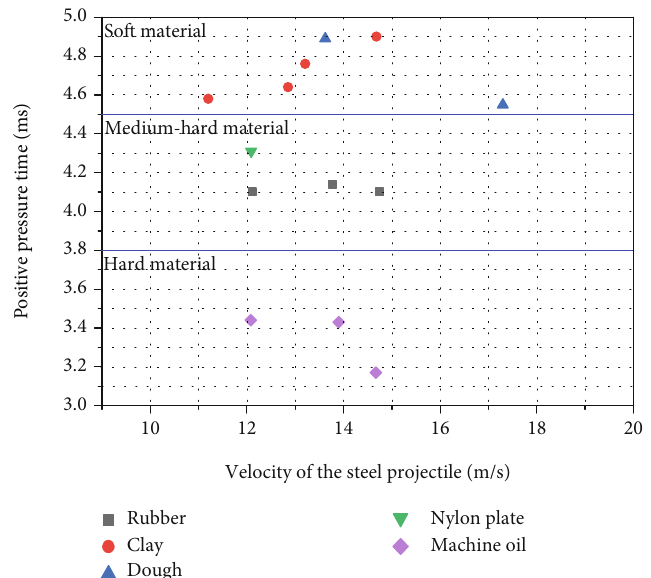
Figure 20: Positive pressure time of stress waves in di ff erent experimental